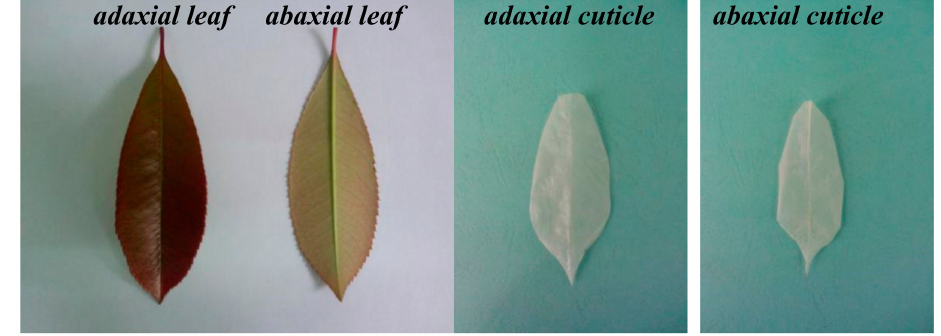
Figure 1. Graph of selected adaxial (PAC) and abaxial (PBC) cuticle as well as adaxial and abaxial Photinia serrulata